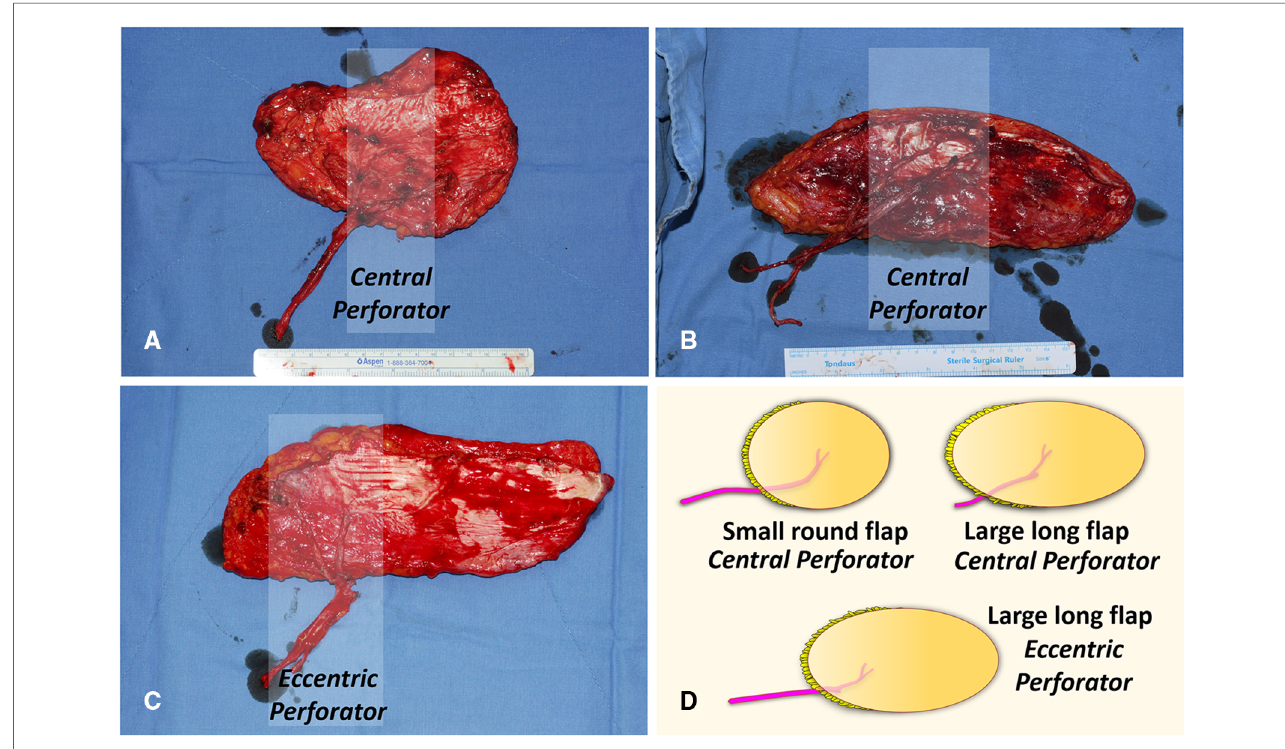
FIGURE 3 Anterolateral thigh perforator (ALTP) fl aps with various shapes and sizes used for soft tissue reconstruction around the knee. ( A ) ALTP fl ap with small round skin paddle supplied by perforators located in the central area of the fl ap (Cen-ALTP fl ap). ( B ) ALTP fl ap with large long skin paddle supplied by perforators located in the central area of the fl ap (Cen-ALTP fl ap). ( C ) ALTP fl ap with large long skin paddle supplied by perforators located eccentrically in the fl ap (Ecc-ALTP fl ap). ( D ) Cen-ALTP fl ap is fi rst considered for use due to their stable blood supply. As the defect size increases, an ALTP fl ap is required in the order of Cen-ALTP fl ap with small round skin paddle, Cen-ALTP fl ap with large long skin paddle, and Ecc-ALTP fl ap with large long skin